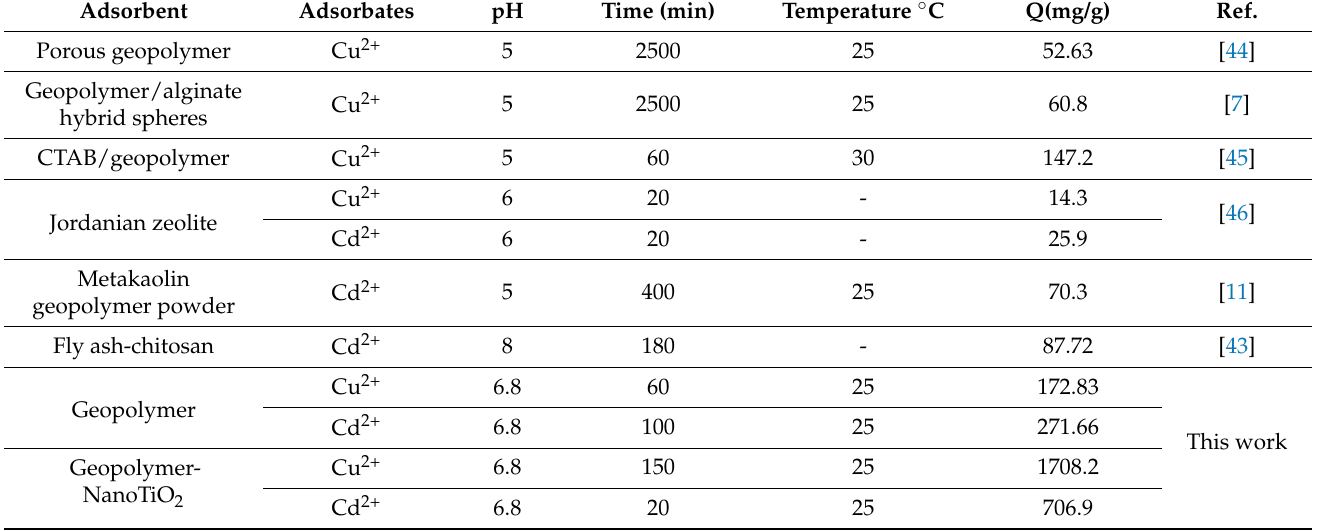
Table 5. Comparison between the adsorption capacity of synthesized geopolymers and that of other